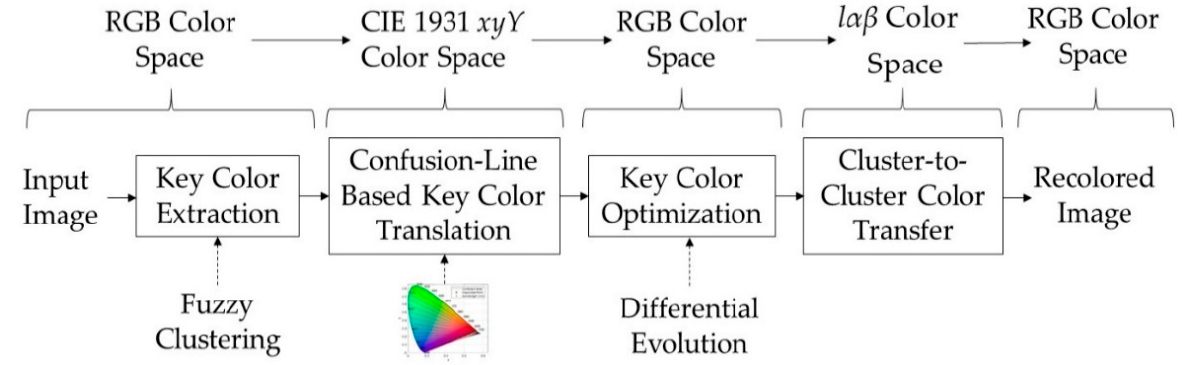
Figure 2. The basic structure of the proposed recoloring method.